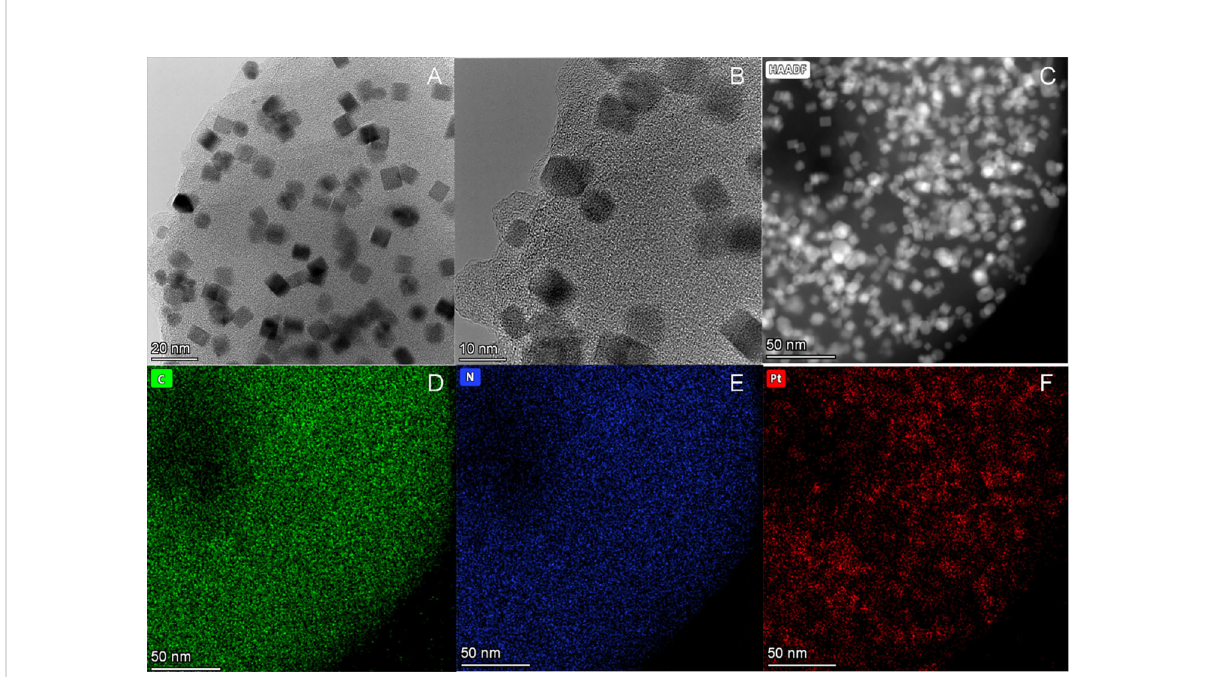
FIGURE 2 Structural and morphological characterization of Purp@COP. (A) Transmission electron microscope (TEM) images of Purp@COP (scale, 20 nm). (B) High-resolution TEM images of Purp@COP (scale, 10 nm). (C) High-angle annular dark- fi eld scanning transmission electron microscope (HAADF-STEM) of Purp@COP (scale, 50 nm). (D – F) Energy-dispersive spectrum (EDS) elemental mapping images of C, N, and Pt (scale, 50